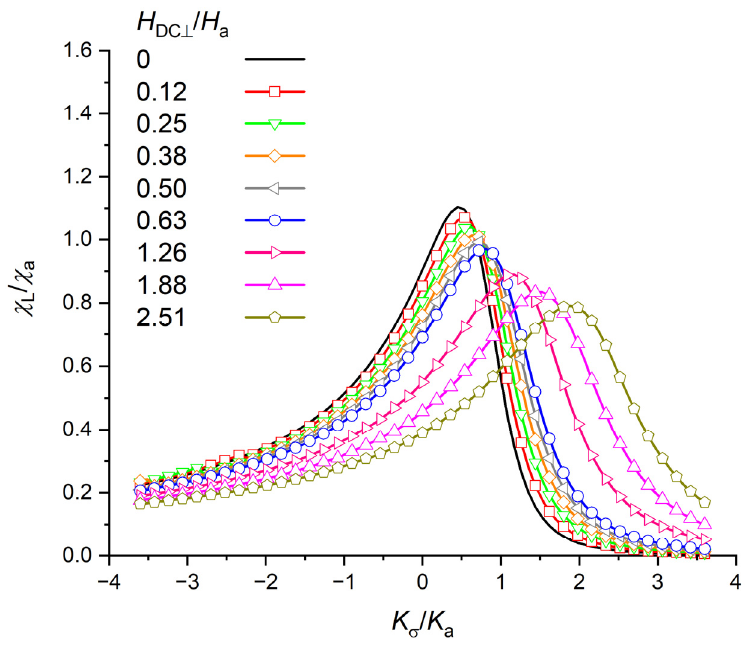
Figure 10. Relative susceptibility components ( χ L / χ a ) versus anisotropy ratio K σ / K a with λ s = 30 ppm for different orthogonal field.